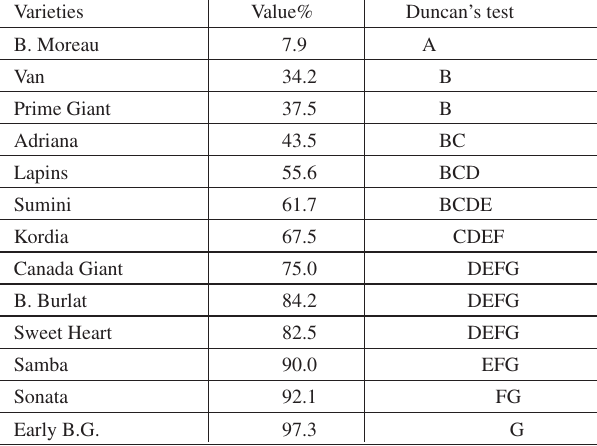
Table 3. Average of flowers percentage destroyed by spring frost, in orchard 3 Varieties